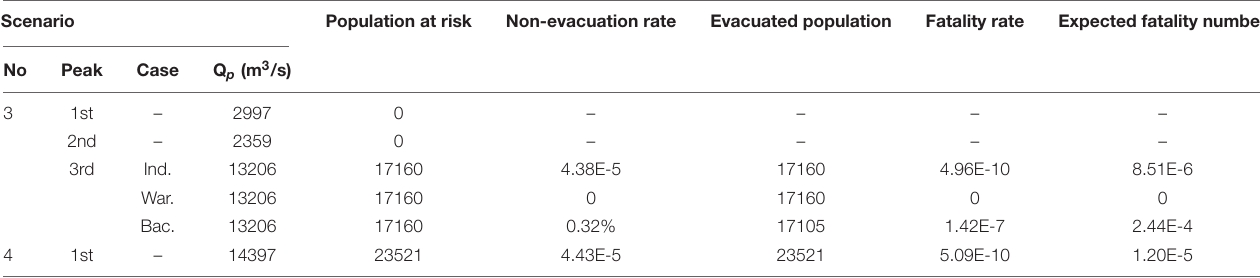
TABLE 6 | Risk assessment results in Mianyang City.